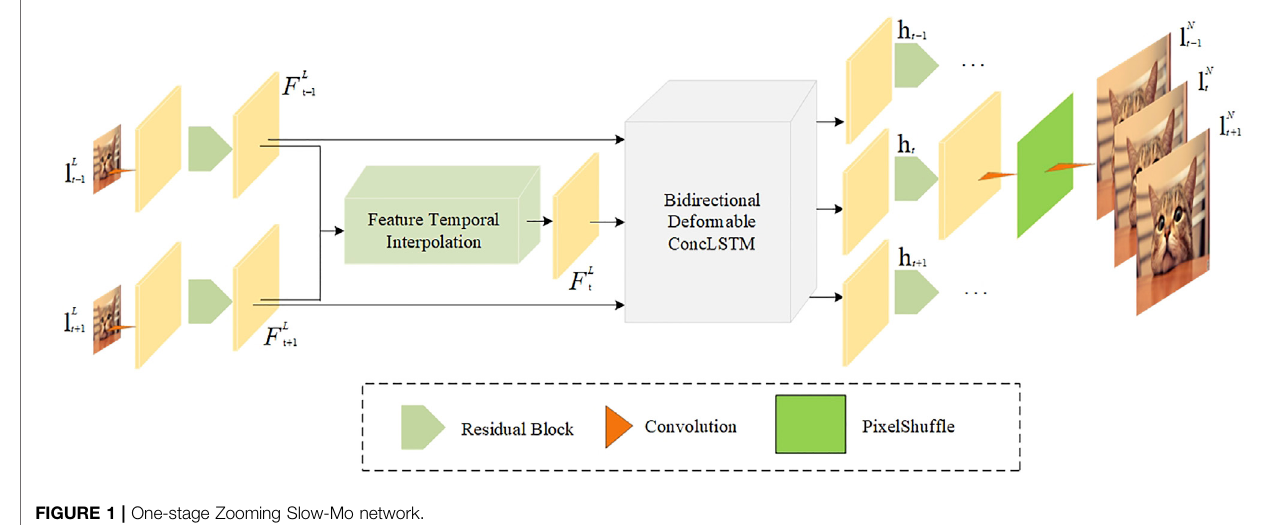
FIGURE 1 | One-stage Zooming Slow-Mo network.